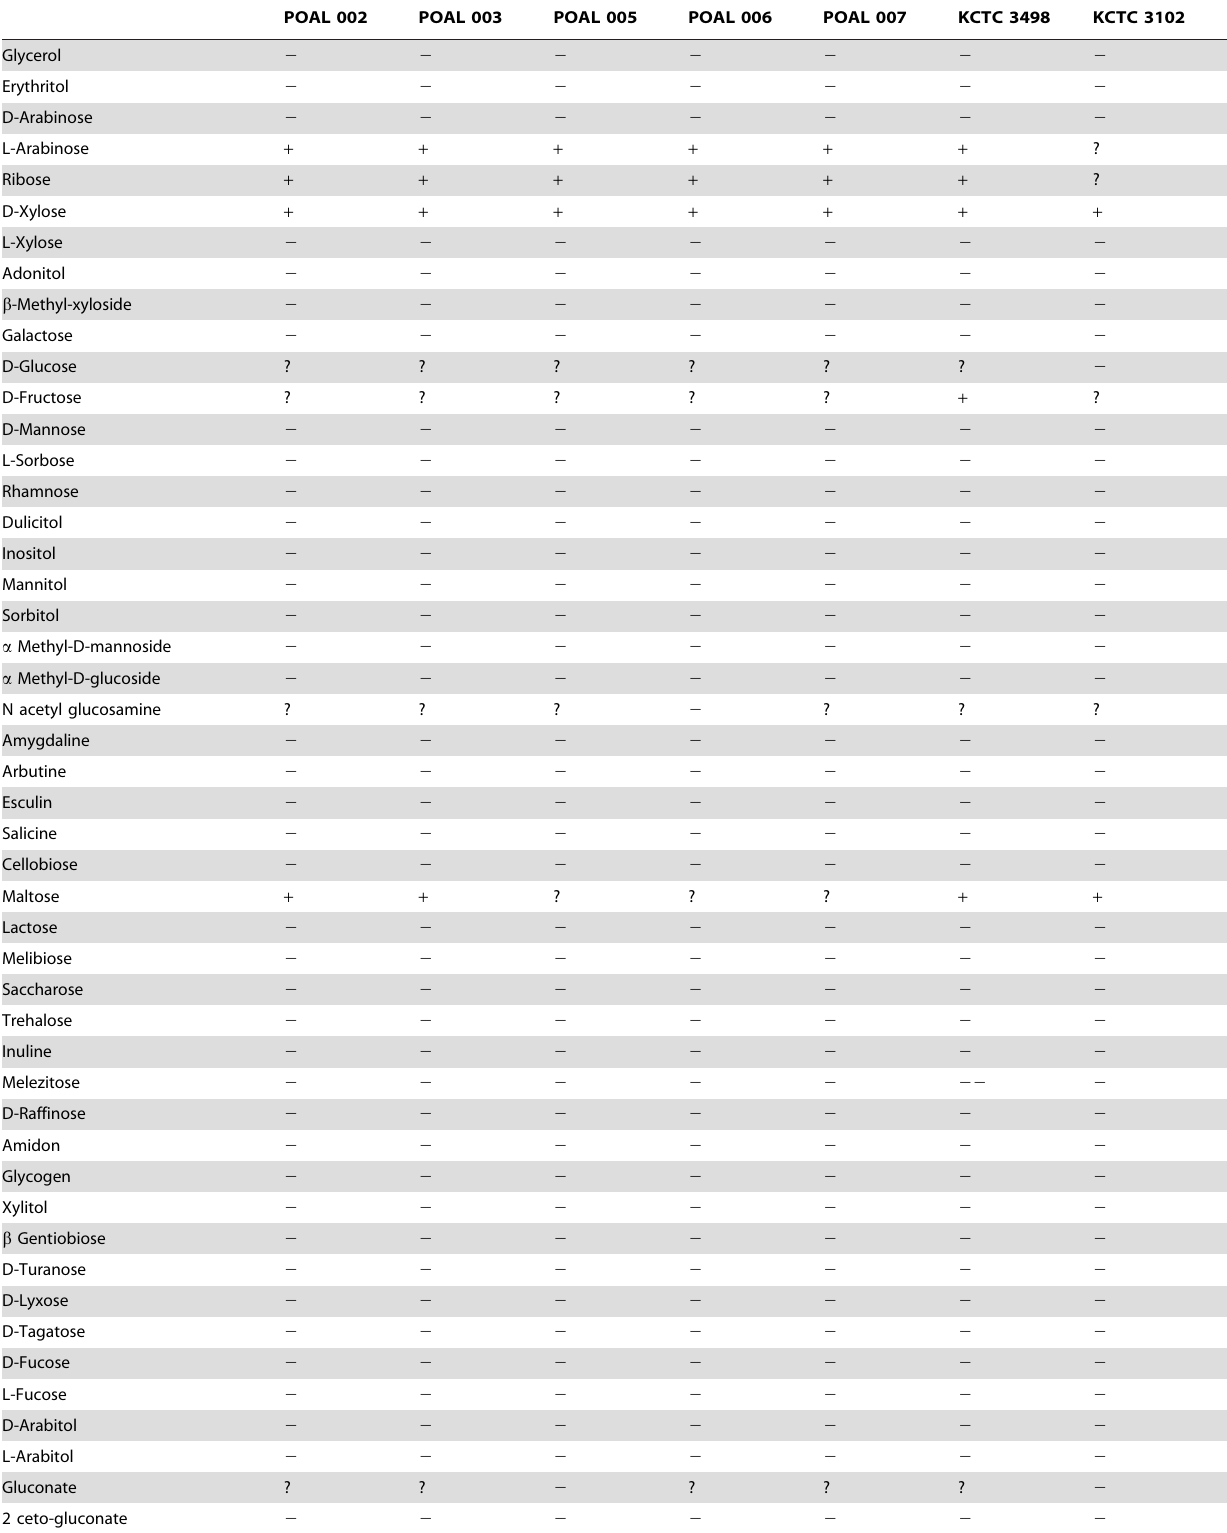
Table 2. Biochemical and physiological characteristics of lactic acid bacteria*.